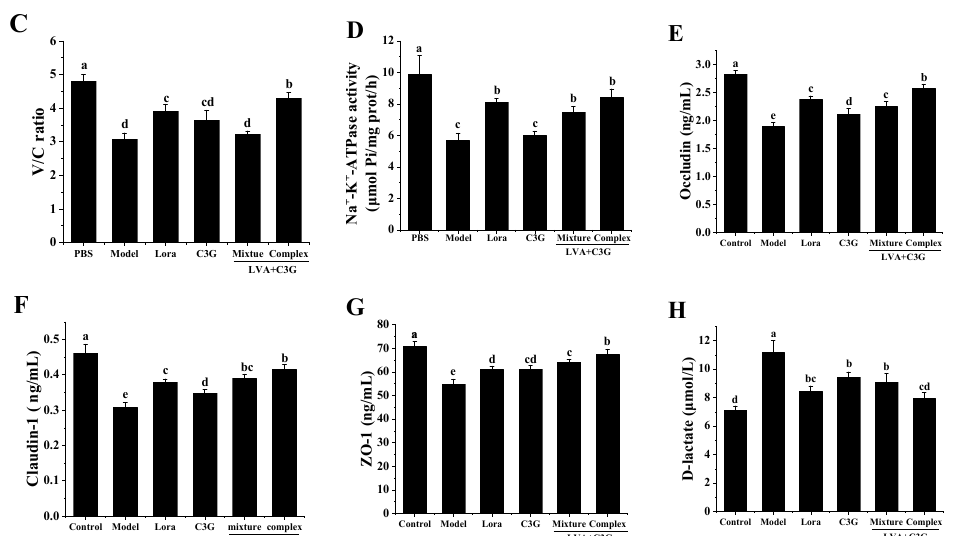
Figure 3. The effect of the C3G-associated samples on the physical barrier function of the intestinal epithelium. ( A ) H&E-stained cecum sections. Red arrows indicate mucosal atrophy and edema, and black arrows indicate crypt hyperplasia. ( B ) SEM observation of the cecum villi. ( C ) The V/C ratio. ( D ) Intestinal Na+-K+-ATPase activity. ( E ) Occludin expression. ( F ) Claudin-1 expression. ( G ) ZO-1 expression. ( H ) Serum D-lactic acid. Significant differences ( p < 0.05) are identified by different letters.